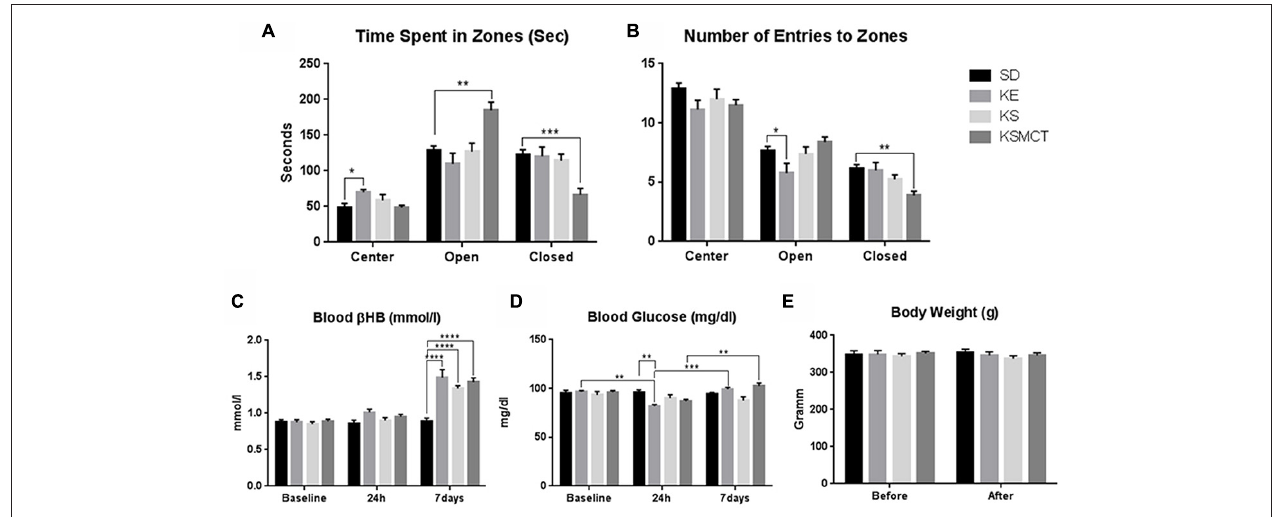
FIGURE 3 | Response of Wistar Albino Glaxo/Rijswijk (WAG/Rij) rats to 7 days oral administration of exogenous ketone supplementation. (A) More time spent in open arms (open) and less time spent in closed arms (closed) by KSMCT group were demonstrated compared to control; (B) Less entries in closed arms by KSMCT group and in open arms by KE group; (C) Blood β HB levels were higher in all treatment groups (KE, KS and KSMCT) after 7 days, compared to baseline, 24h and control. (D) Blood glucose levels decreased after 24 h in KE group compared to control and baseline, but increased after 7 days compared to 24 h in KE and KSMCT group; (E) Body weight did not change significantly in either groups. Abbreviations: SD, standard rodent chow + water ( ∼ 2.5 g/kg b.w. water/day); KE, SD + ketone ester (1,3-butanediol-acetoacetate diester, ∼ 2.5 g/kg b.w./day); KS, SD + beta-hydroxybutyrate-mineral salt ( β HB-S; ∼ 2.5